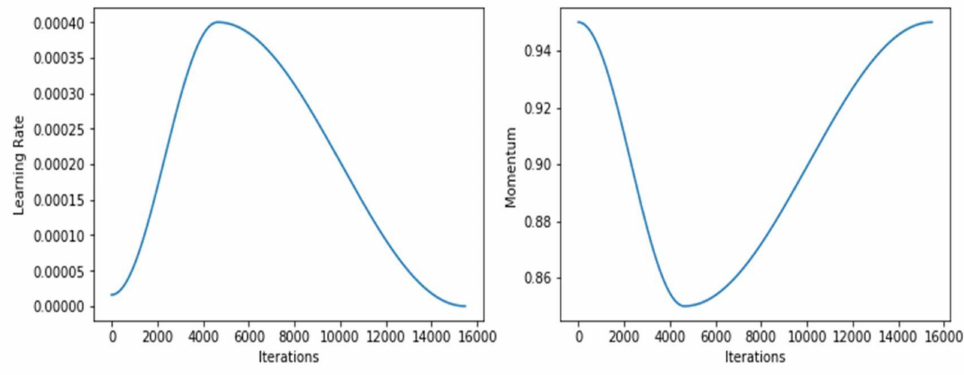
Figure 9. Graphs of learning rate and momentum over iterations after fine-tuning